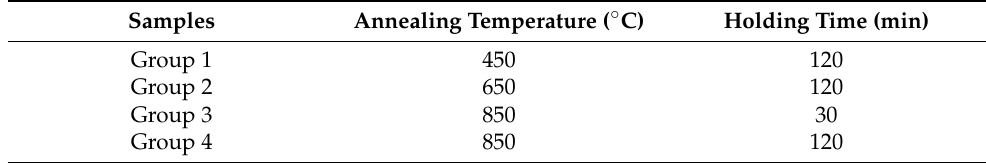
Figure 2. YFX-16 electrical resistance furnace used for heat treatment. Table 3. Heat treatment parameters for samples.